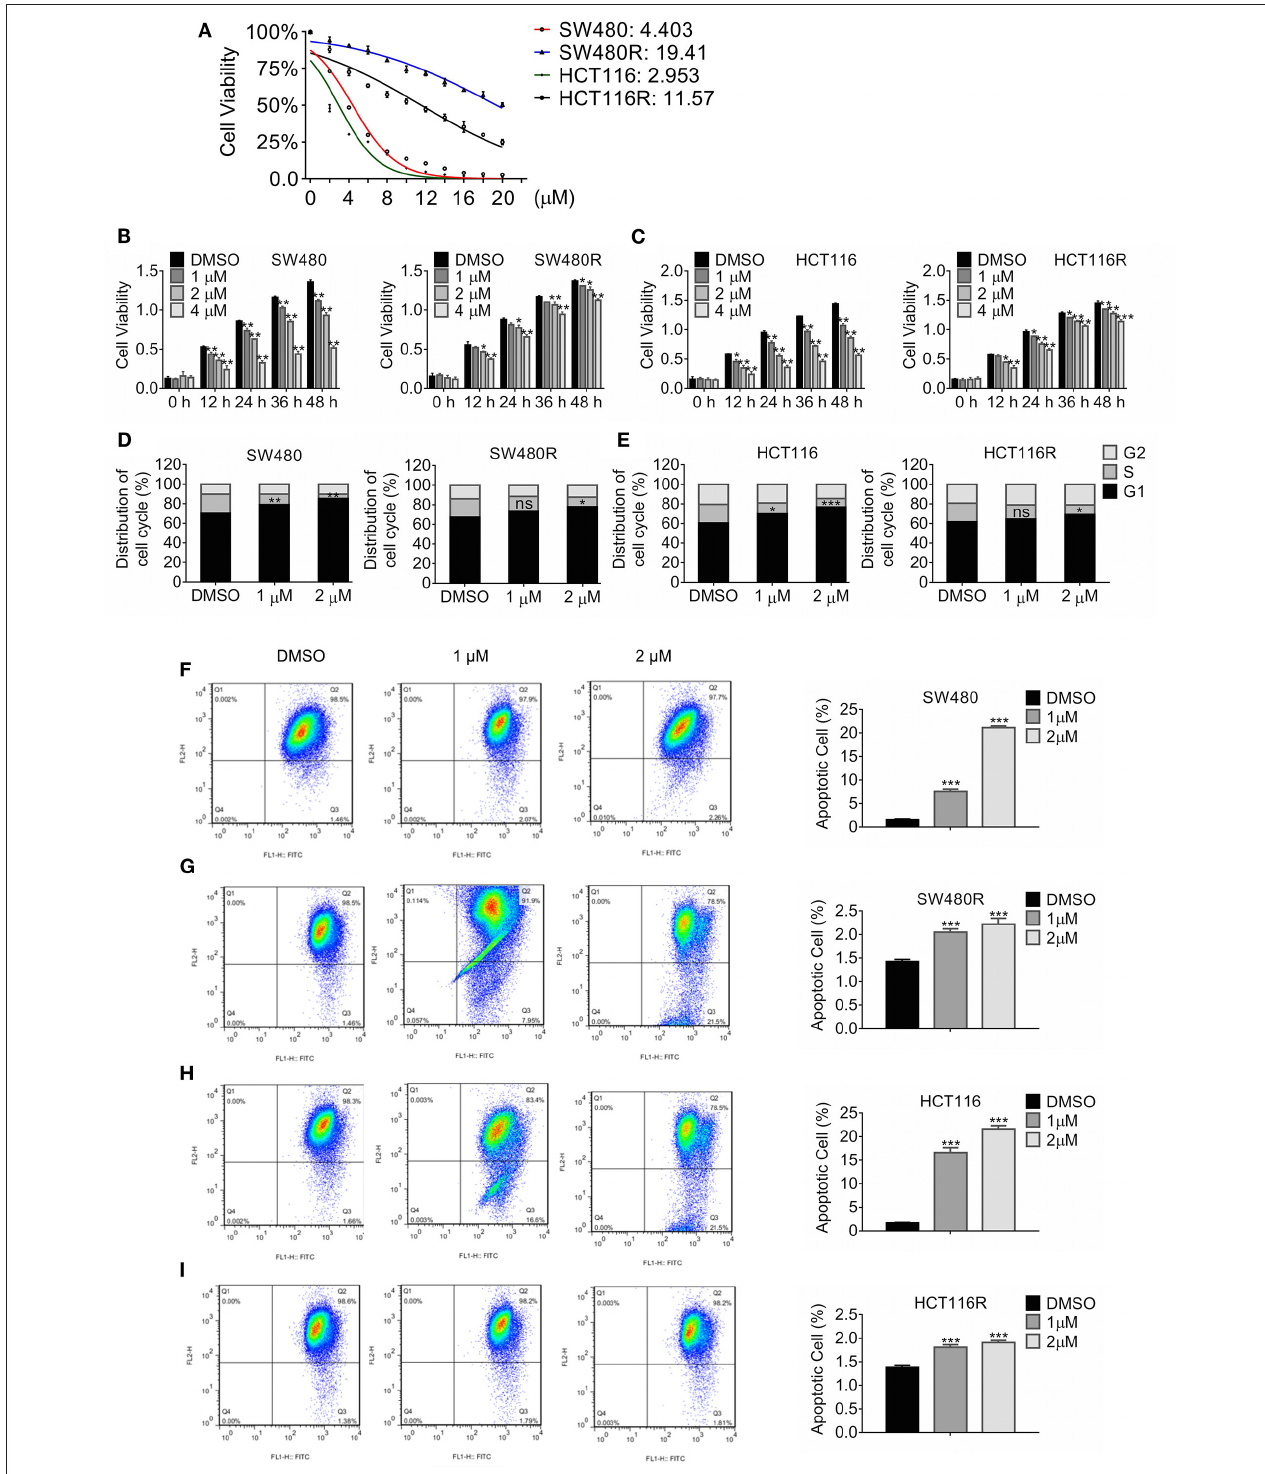
FIGURE 1 | Growth profile of Regorafenib-resistant cells. (A) The viability of the indicated cells was detected by MTT assay post-treatment with regorafenib 72h. The IC50 values for the indicated cells were estimated. Data are mean ± SD (error bars) of three individual experiments. (B,C) The cell viability of SW480R and HCT116R, as well as their parental cells, was detected by MTT assay post-treatment with increasing concentrations of regorafenib at the indicated time-point. Data are mean ± SD (error bars) of three individual experiments. * P < 0.05, ** P < 0.01, vs. DMSO. (D,E) Distribution of cell cycle of SW480R and HCT116R, as well as the parental